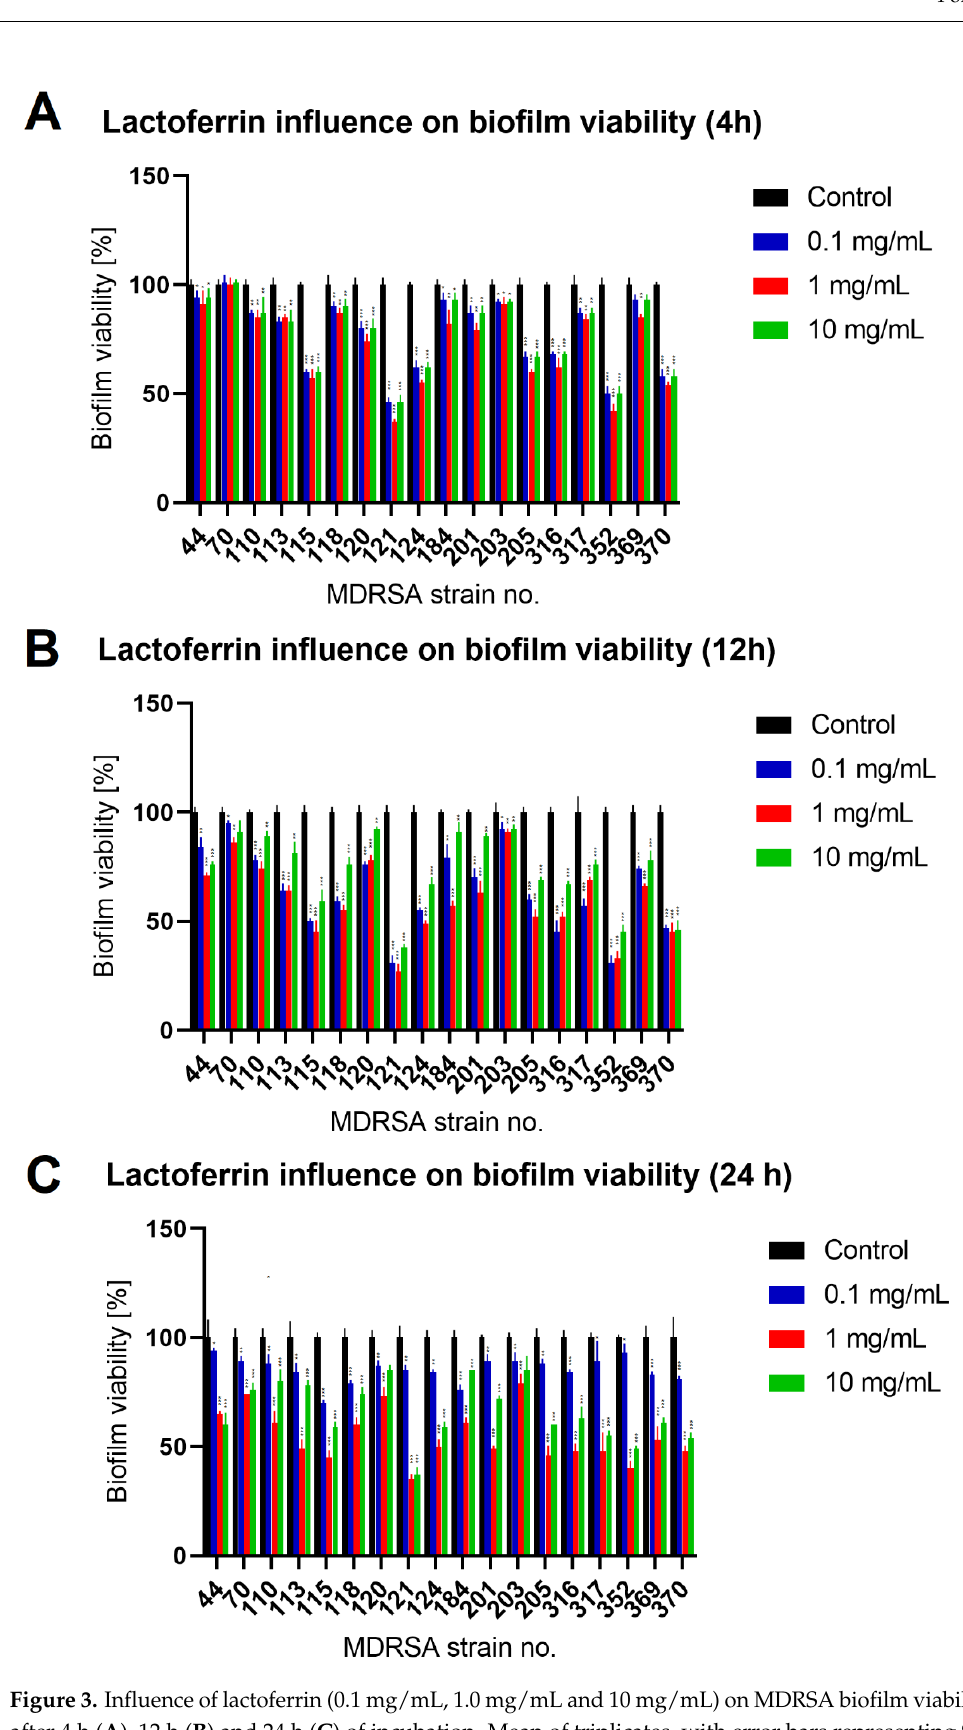
Figure 3. Influence of lactoferrin (0.1 mg/mL, 1.0 mg/mL and 10 mg/mL) on MDRSA biofilm viability after 4 h ( A ), 12 h ( B ) and 24 h ( C ) of incubation. Mean of triplicates, with error bars representing SD. Statistical analysis was performed using t -test, p < 0.05 (*), p < 0.01 (**), p < 0.001 (***).